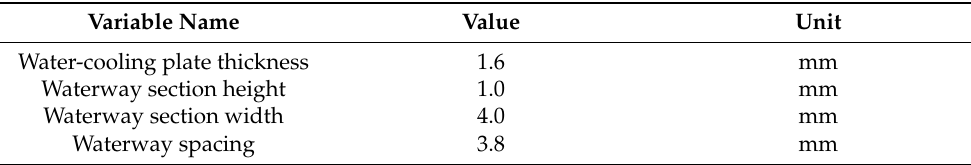
Table 2. Main parameters of the waterways.